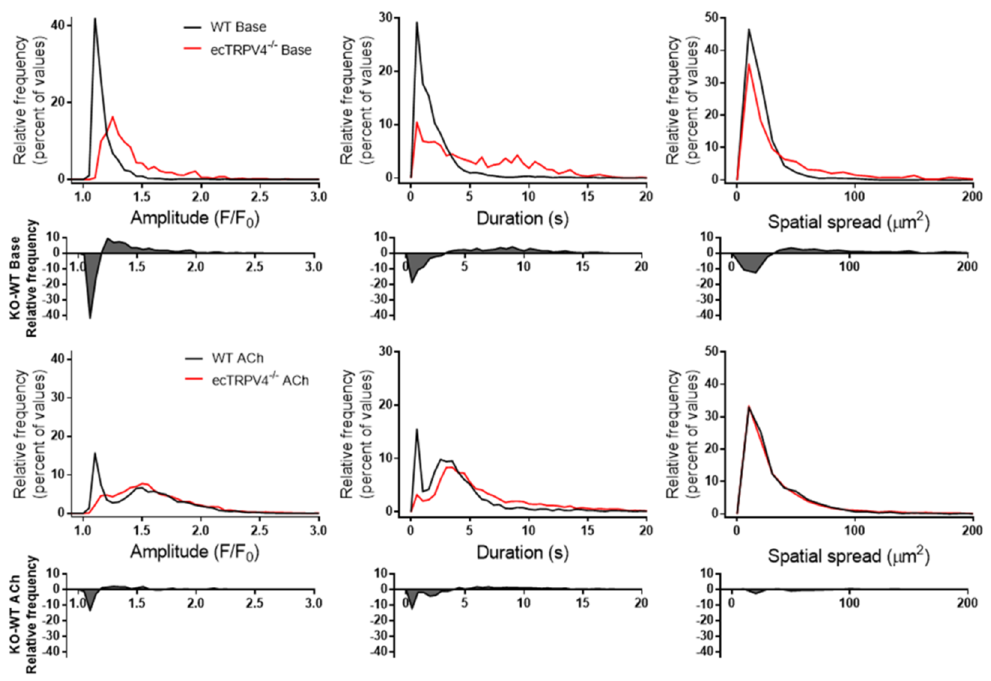
Figure 3. Separation of ecTRPV4 −/− and WT Ca 2+ event parameter distributions. Histograms show relative frequency distributions of amplitude, duration and spatial spread values under basal (top) and ACh-stimulated (10 −8 M) conditions (bottom). Shaded plots show difference between ecTRPV4 −/− and WT histograms for each parameter (KO-WT).